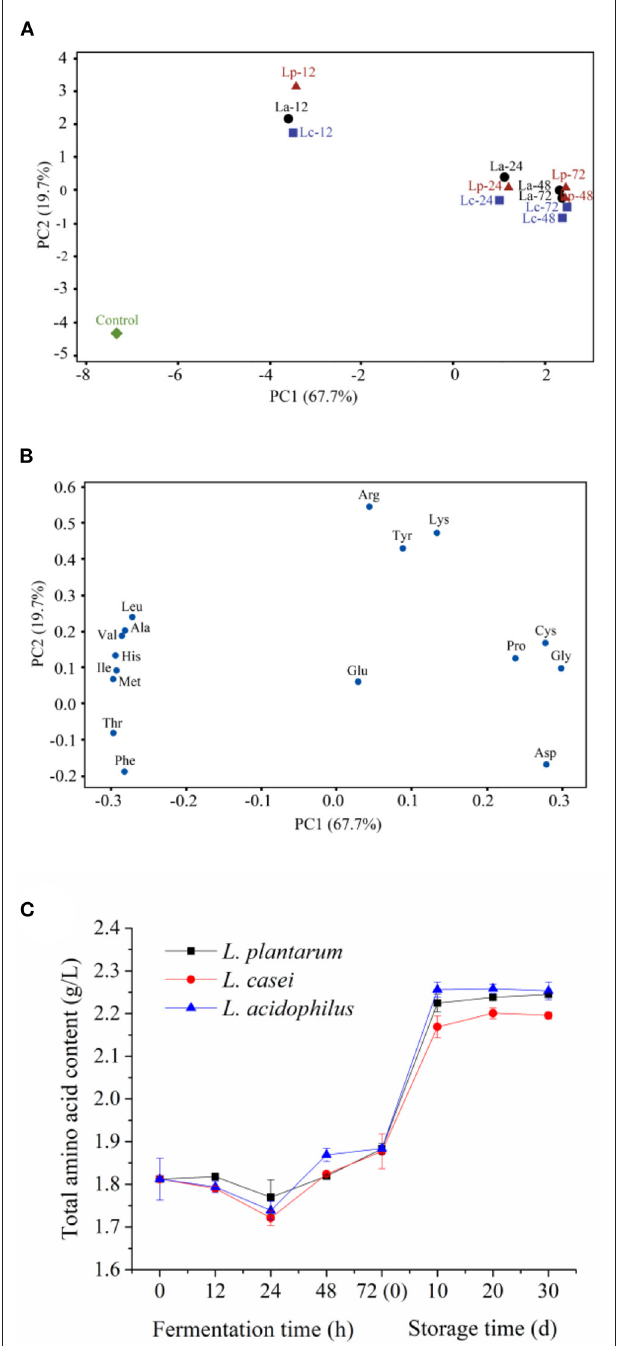
FIGURE 2 | Principal component analysis of free amino acid profile in apple juice during fermentation by the three LAB strains [ (A) , score plot; (B) , loading plot] and changes in total free amino acids (C) . “Control,” Unfermented apple juice; “La,” Apple juice fermented by L. acidophilus ; “Lp”, Apple juice fermented by L. plantarum ; “Lc”, Apple juice fermented by L. casei . In (A) , the number followed with the name of strain indicated the time of